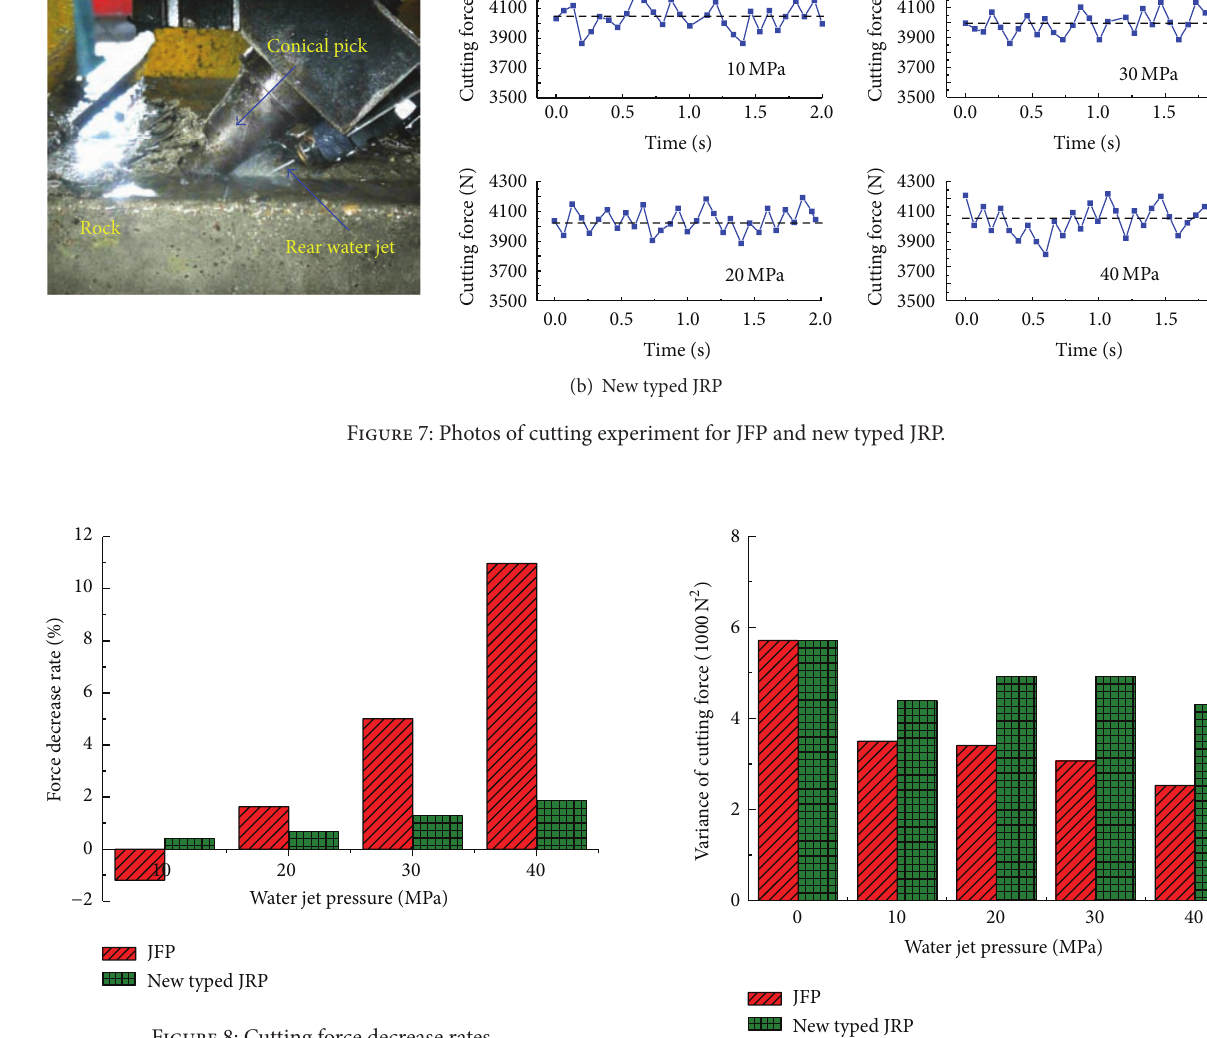
Figure 8: Cutting force decrease rates.